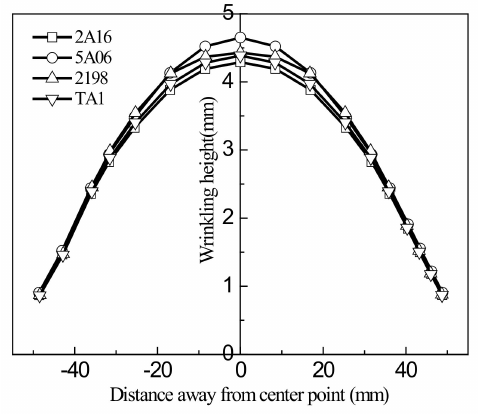
Figure 23. Ridge line height versus center distance in the principal tensile